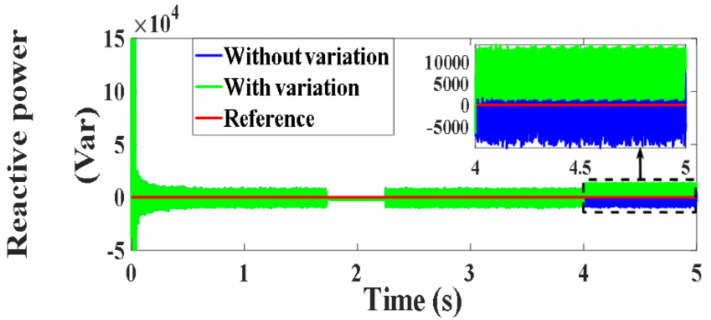
Figure 164. Reactive power under PVC